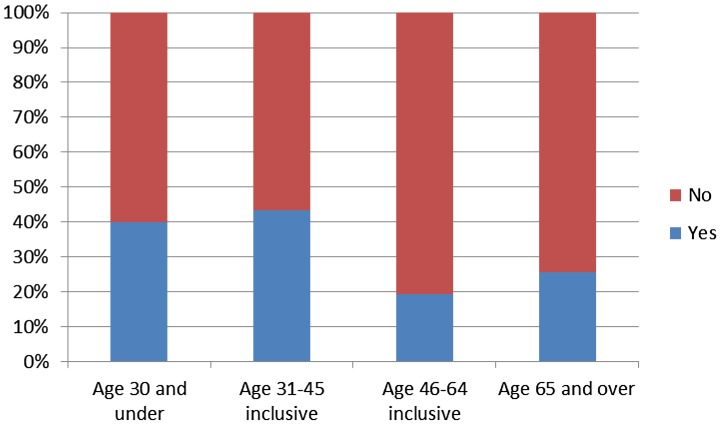
Percentage of patients who correctly knew the national physical activity guidelines divided into age groups.